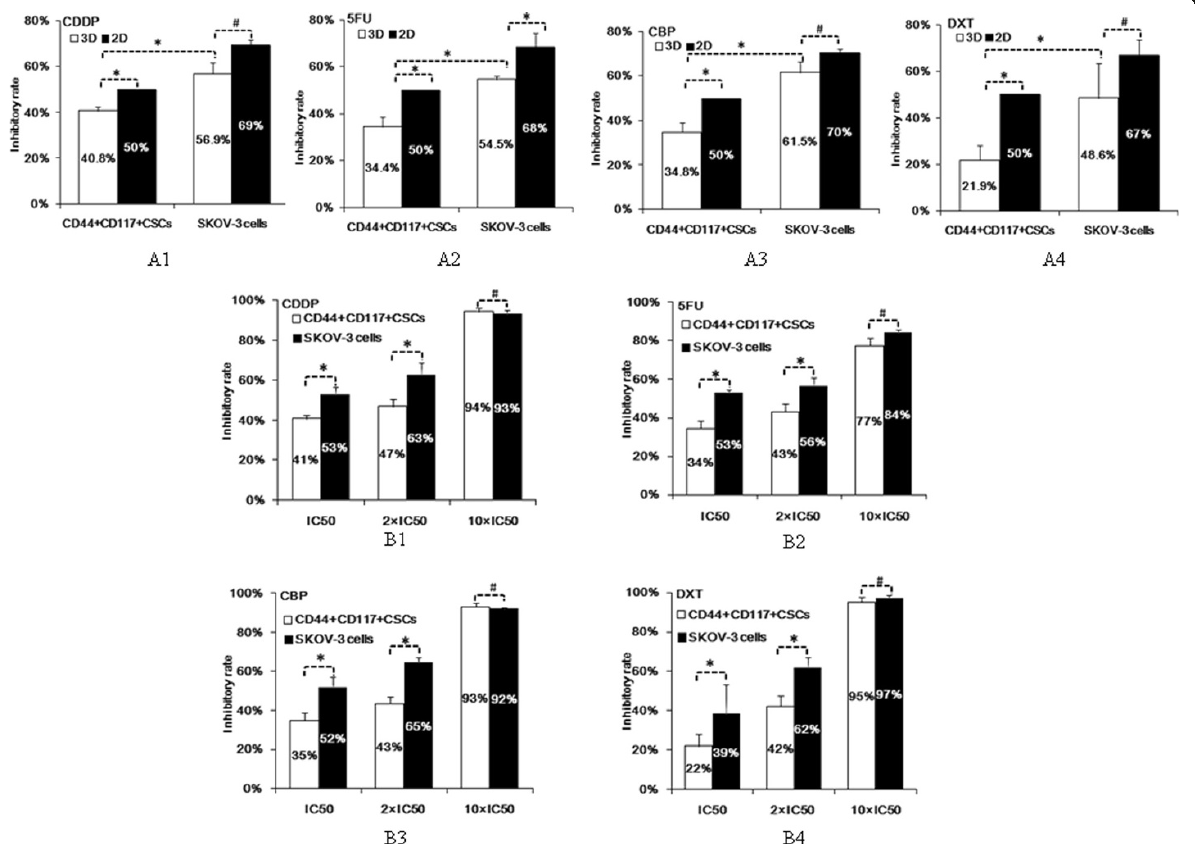
Figure 4 CD44 + CD117 + CSCs with multidrug resistance property in 3D culture. A shows the cellular growth inhibitory rates of anticancer drugs 5FU, CDDP, CBP, and DXT to the CD44 + CD117 + CSCs and the SKOV-3 cells in 3D culture and the 2D one, respectively. IC 50 concentrations of 5FU, CDDP, CBP and DXT were 17.18 μ g/mL, 18.6 μ g/mL, 20.5 μ g/mL, and 72 μ g/mL, respectively, in the CD44 + CD117 + CSCs group. B likewise indicates the inhibitory rates of 5FU, CDDP, CBP, and DXT to CD44 + CD117 + CSCs and SKOV-3 cells in IC 50 concentration, two-folds IC 50 concentration and ten-folds IC 50 concentration, respectively. * P < 0.05 and # P >